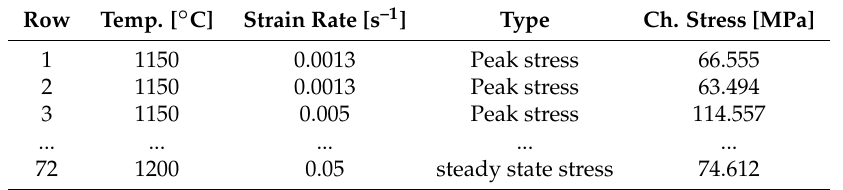
Table 6. Dataset used for training the ANNs to predict the position of the characteristic stresses (peak, critical and steady state stress), with the first three rows and the last row shown. Training inputs; temperature, strain rate and parameter type. Target output; characteristic